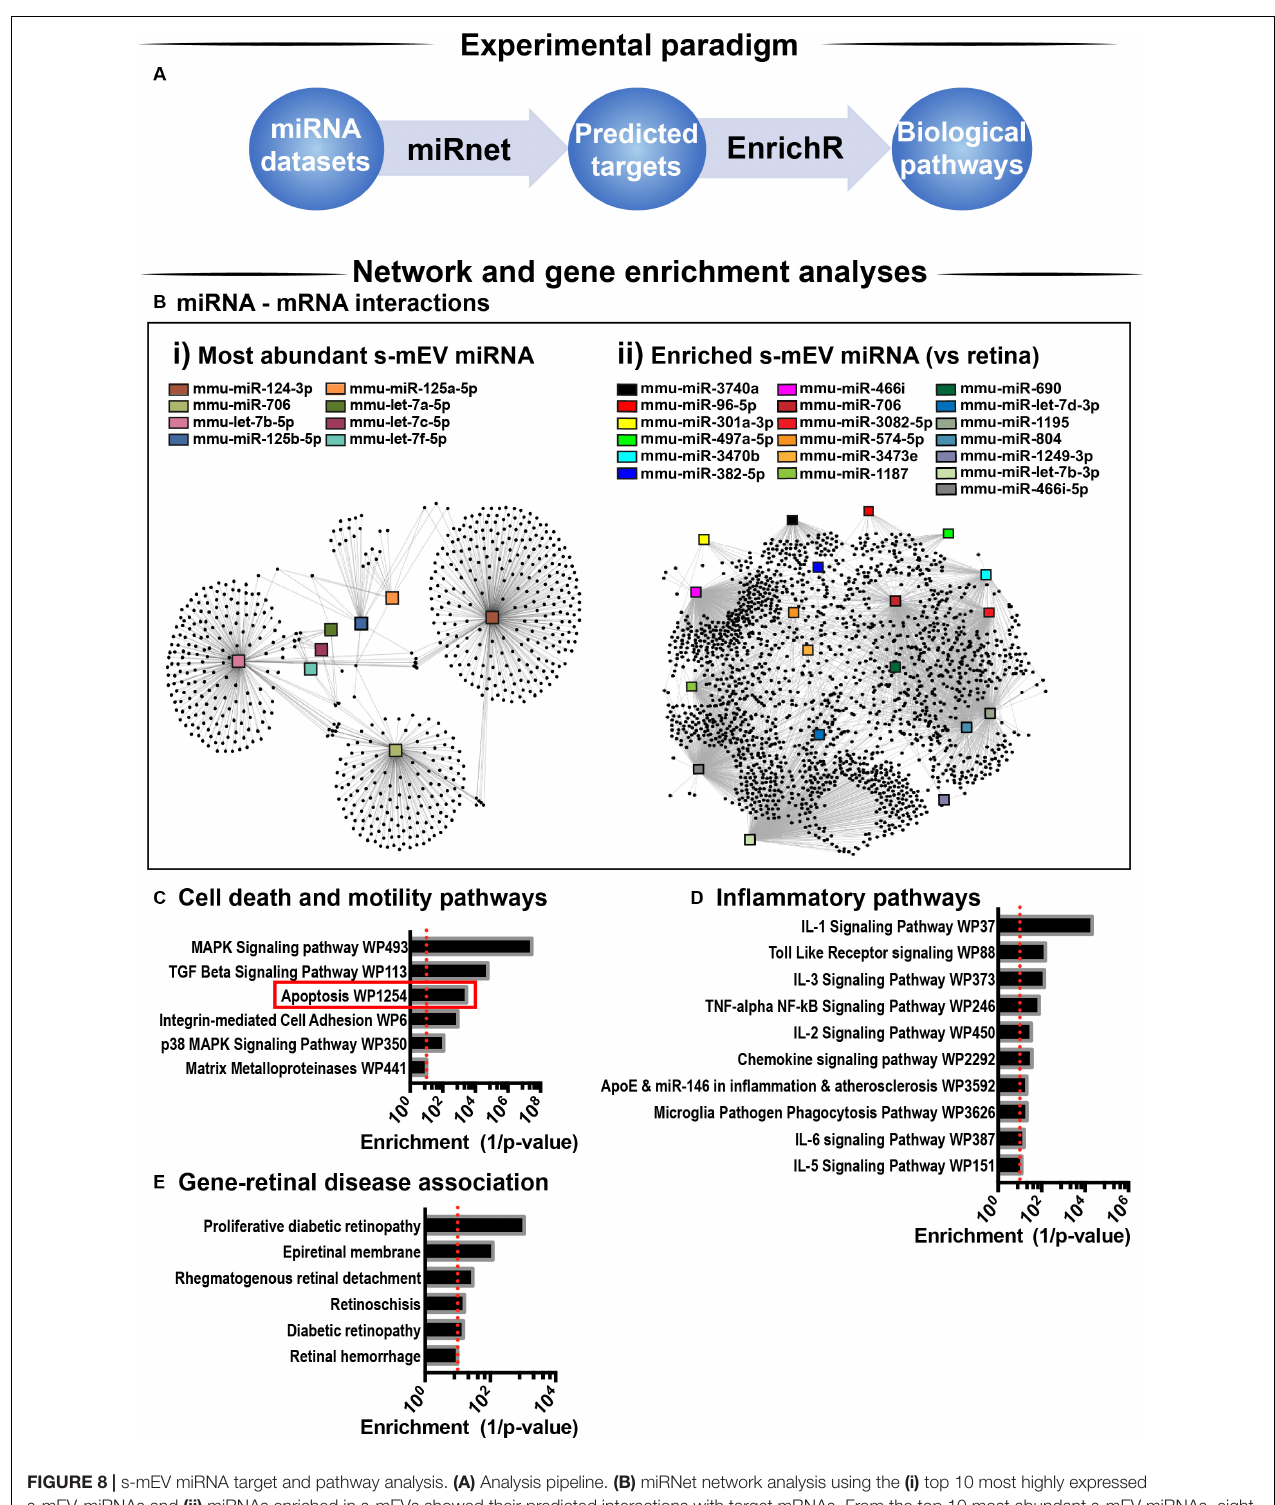
FIGURE 8 | s-mEV miRNA target and pathway analysis. (A) Analysis pipeline. (B) miRNet network analysis using the (i) top 10 most highly expressed s-mEV-miRNAs and (ii) miRNAs enriched in s-mEVs showed their predicted interactions with target mRNAs. From the top 10 most abundant s-mEV miRNAs, eight formed an interconnected network, with miR-124-3p, miR-706 and let-7b-5p having the largest number of predicted targets. From the most enriched s-mEVs miRNAs, miR-466i-3p, miR-466i-5p and miR-1195 had the largest targetomes. Pathway analysis was performed using the predicted targets of the most abundant (Bi) and most enriched (Bii) miRNA, collectively showing a significant enrichment of pathways pertaining to (C) cell survival and motility, (D) inflammatory processes and oxidative stress ( P < 0.05). (E) Enrichment analysis was also performed against DisGeNet (database containing gene-disease associations) revealing that a number of retinal diseases were significantly associated with the targets of s-mEV-miRNAs ( P < 0.05).